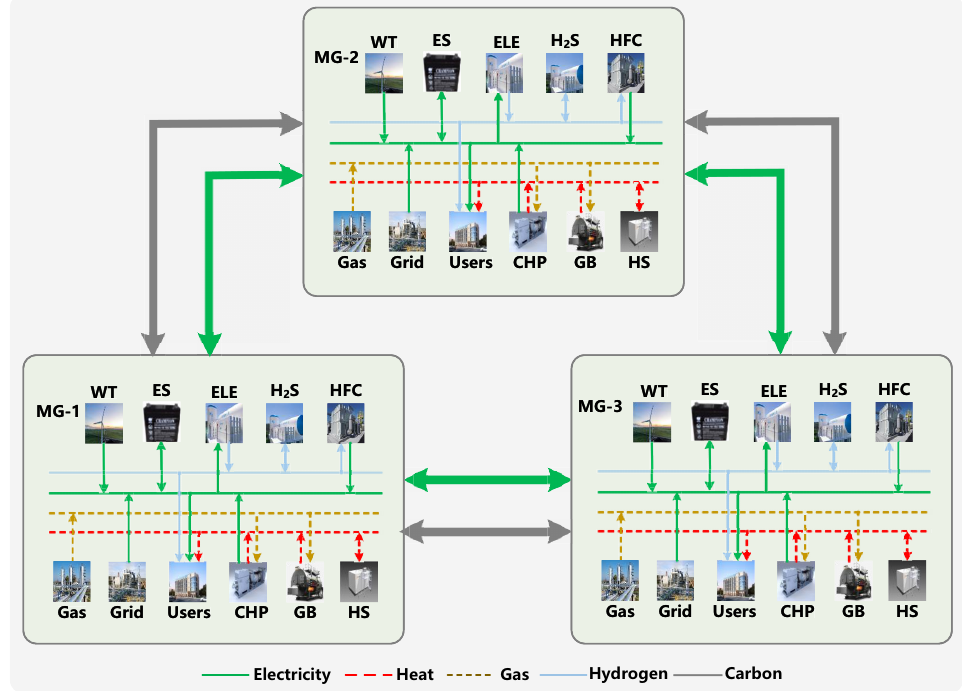
Figure 2. The schematic model of the microgrid network (MG: